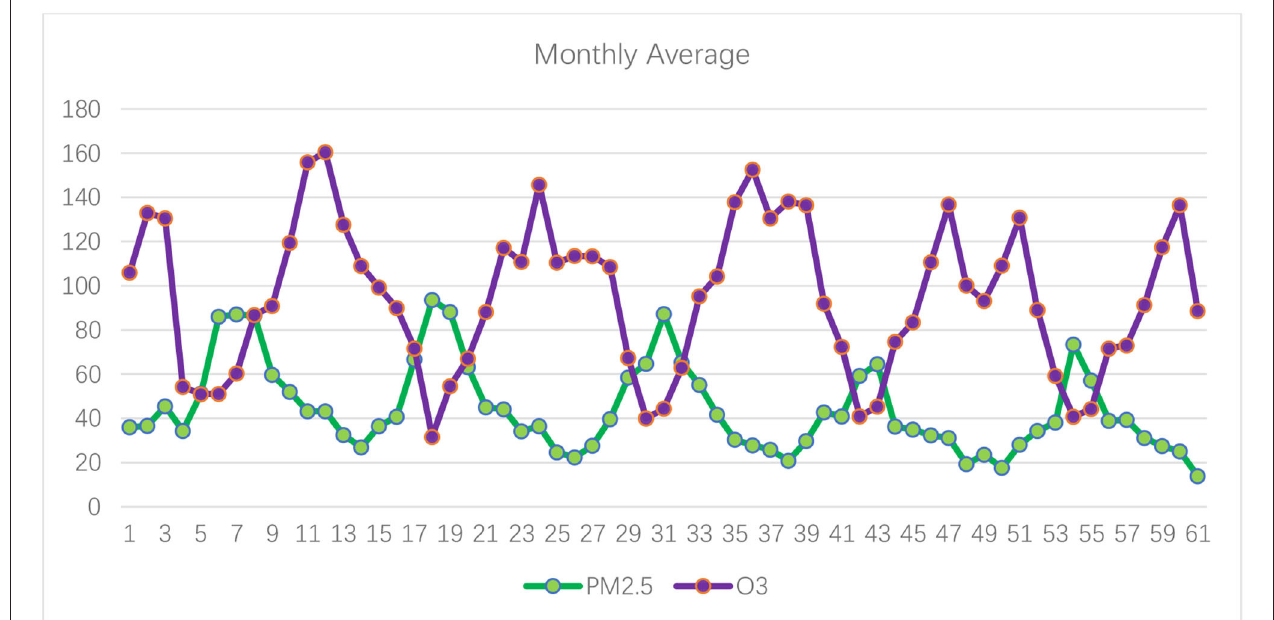
FIGURE 4 | Monthly average of PM2.5 and O 3 of Hefei from July 2016 to July 2021 ( µ g/m 3 ).